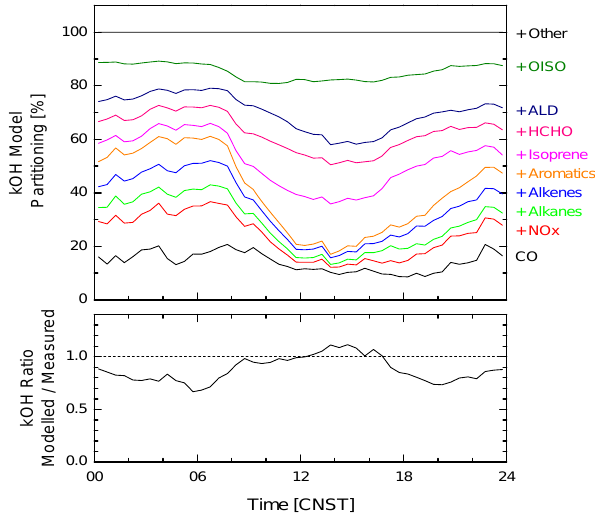
Fig. 7. Upper panel: cumulative OH reactivities of measured and modelled compounds normalized to the modelled, total OH reac- tivity. The data have been averaged for the days of 11 - 26 July 2006. Note: CO, NO x , alkanes, alkenes, aromatics, and isoprene were used as model constraints (Table 2). HCHO, ALD, OISO and Other are products calculated by the RACM model (base case). ’Alkanes’ include H 2 , methane and C 2 -C 12 compounds; ’alkenes’ include C 2 -C 5 compounds; ’ALD’ is the group of modelled ac- etaldehyde and higher aldehydes; ’OISO’ is the group of modelled oxygenated isoprene products (MVK, MACR, CAR4, ISHP, etc.); ’Other’ comprise all other model generated products like ketones, organic peroxides, nitrates, pernitrates, dicarbonyl compounds, etc. Lower panel: Ratio of the modelled to measured total OH